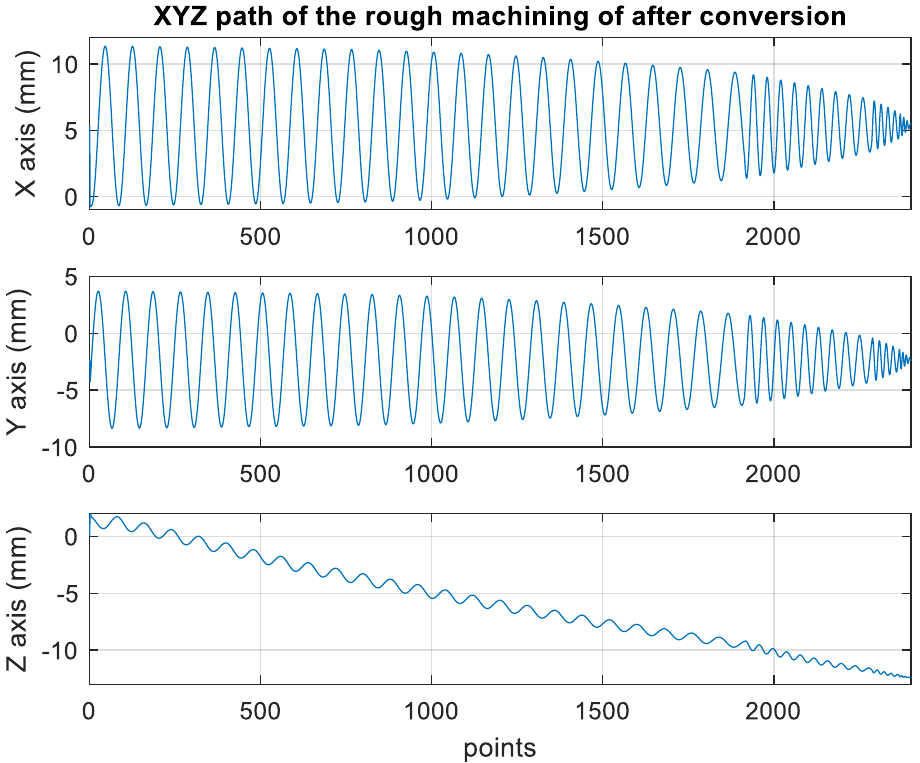
Figure 18. The path of the XYZ axis after converting the rough machining program.